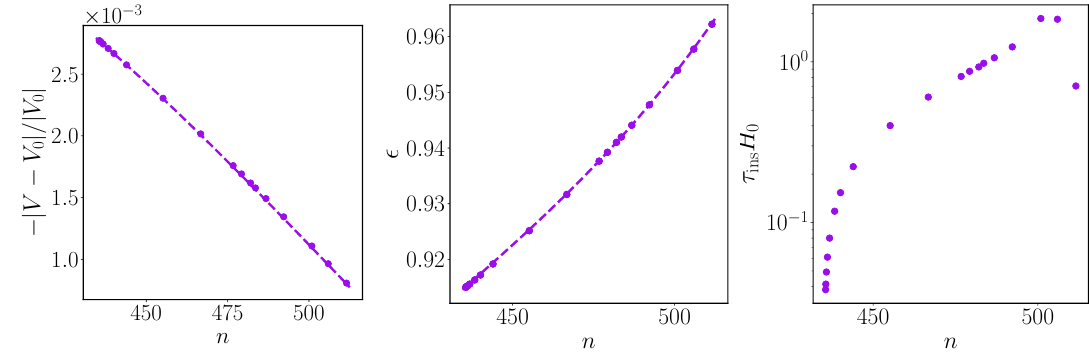
Figure 6 . The volume (left), aspect ratio (middle) and ratio of instability timescale to e-fold period (right) of warped solutions with n on the small volume branch for the special case I < n < n c p = q = 4 . We find that in this regime each unstable symmetric solution evolves to an ellipsoidal solution with (cid:15) < 1 , which has roughly the same internal volume but lower effective potential. The dashed lines represent the interpolation of stationary solutions constructed as described in section 2.4, while the dots represent the end states of evolving a symmetric solution with an ‘ = 2 perturbation. For the aspect ratio, the maximum of the difference is ∼ 10 − 4